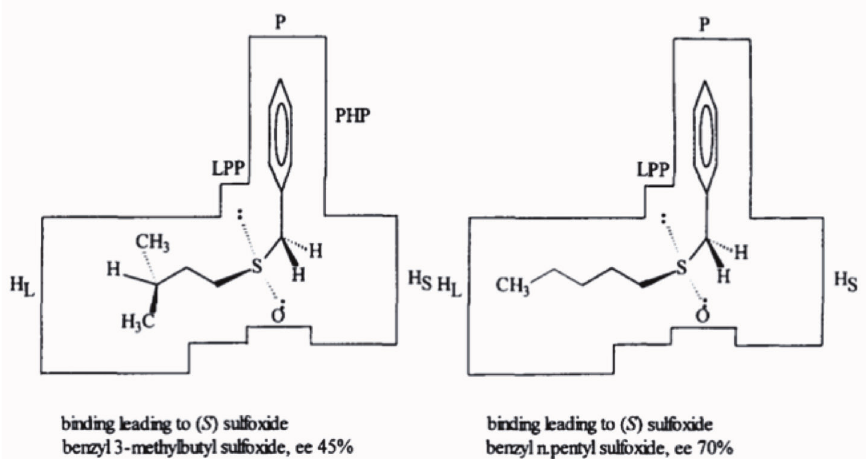
Figure 10 - Binding model for substrates bearing large alkyl groups. (Holland et al. 1997b) Reprinted with permission from Elsevier (Holland et al. 1997b). Copyright 2015